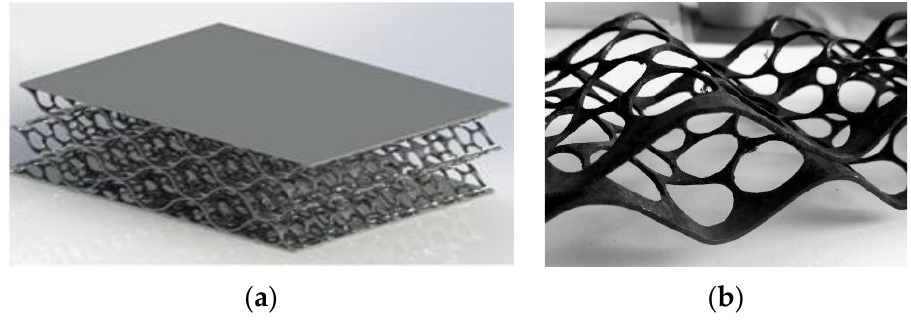
Figure 14. Lattice sandwich panel ( a ), using several perforated profiles ( b ).